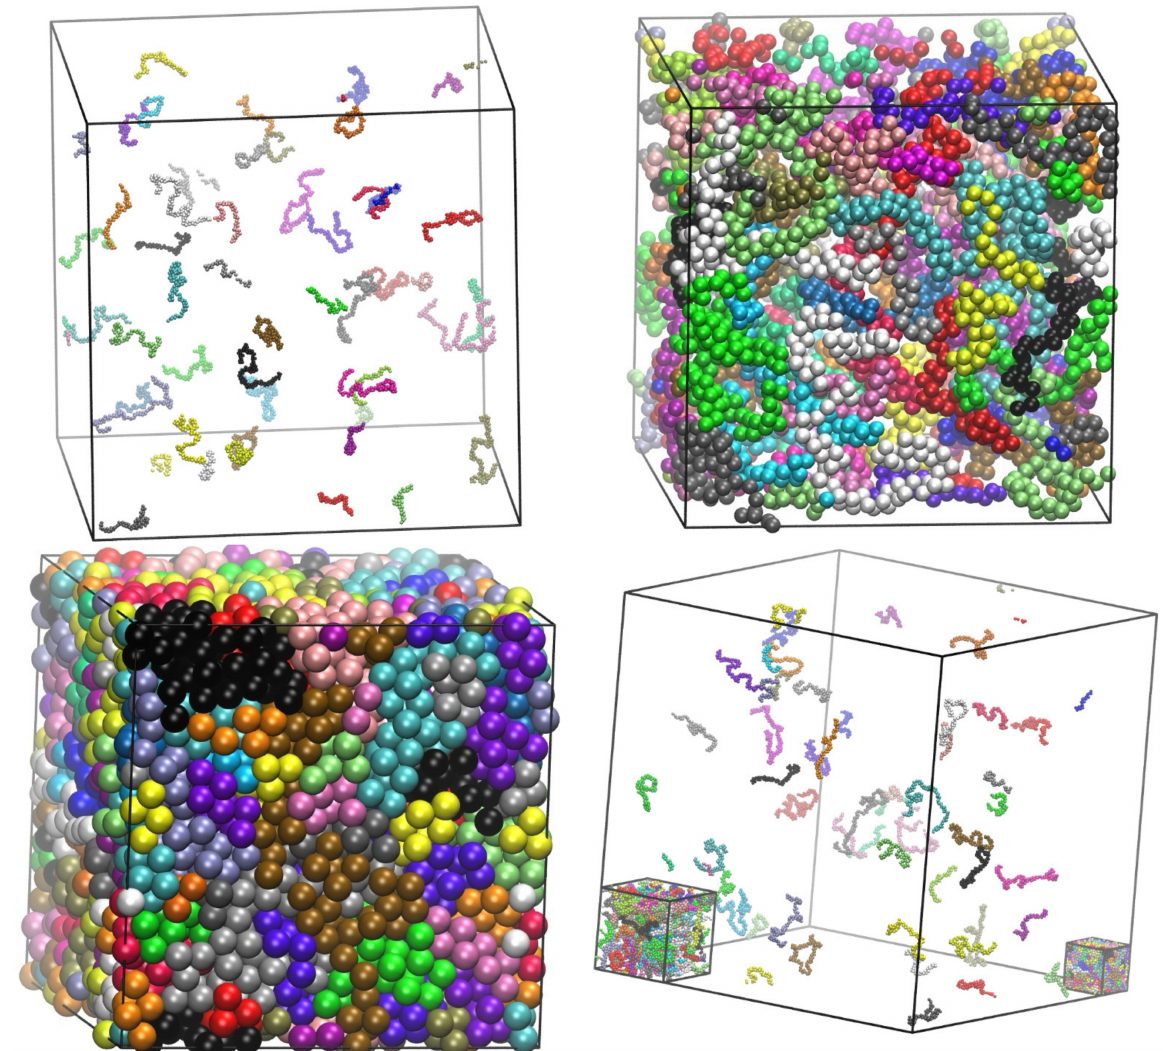
Figure 4. Bulk system configurations of semi-flexible chains of tangent hard spheres of uniform size with average length of N = 100 and an equilibrium angle of θ 0 = 120 ◦ at progressively higher volume fractions, ϕ : ( top left ) 0.001, ( top right ) 0.10 and ( bottom left ) 0.60. ( bottom right ): All three system configurations shown together allowing for a visual comparison of their dimensions. Monomers are colored according to their parent chain. Sphere monomers are shown with coordinates of their centers subjected to periodic boundary conditions. Image created with VMD visualization software [54]. Figure panels are also available as interactive, 3-D images in Supplementary